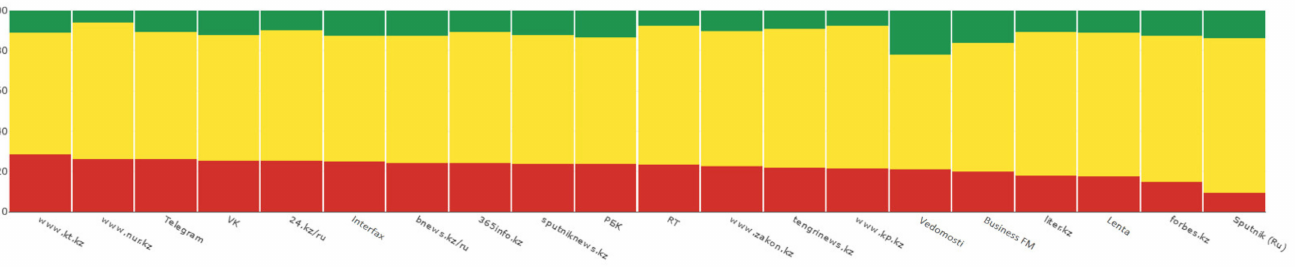
Figure A3. Negative media.